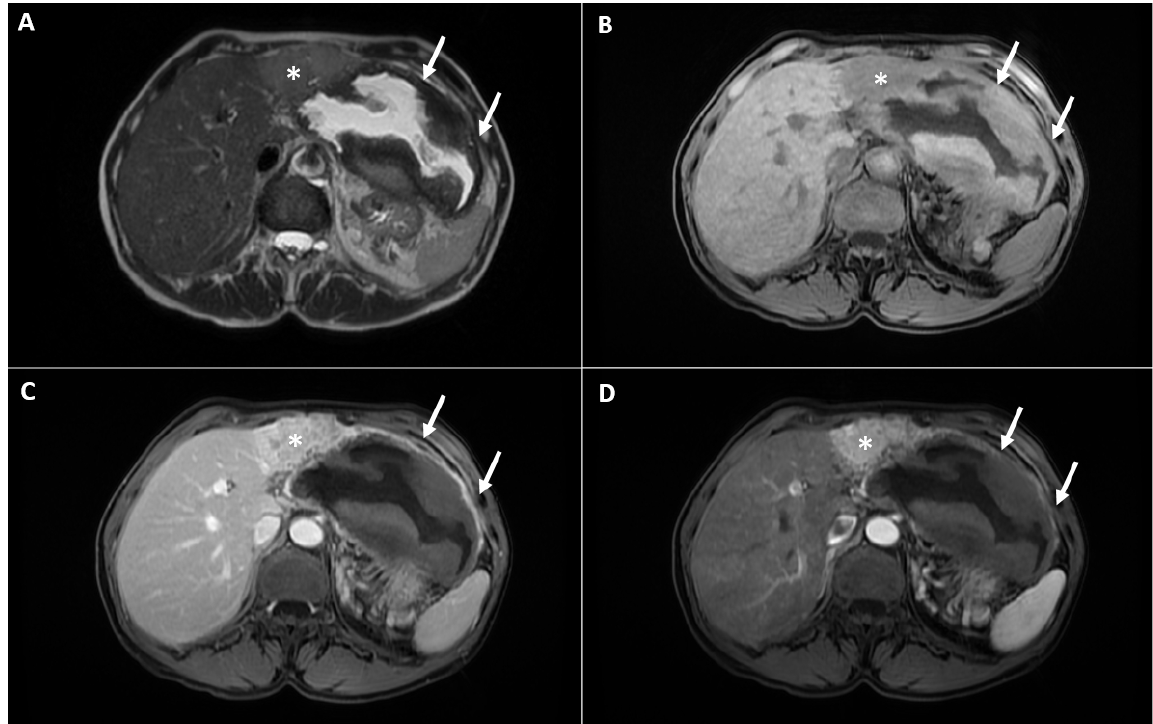
Figure 2. The MRI examination shows a cystic lesion with thickened, irregular walls (arrows) and a solid tumor in liver segment IV adjacent to the cystic component (asterisk) displaying an intermediate signal intensity in the T2-weighted image ( A ), a low signal intensity in the T1-weighted image ( B ) and an intense enhancement in the arterial phase ( C ), with washout in the portal-venous phase ( D ). Note only a slight enhancement of the cystic wall, while there is no enhancement in the necrotic masses along the walls of the cyst.